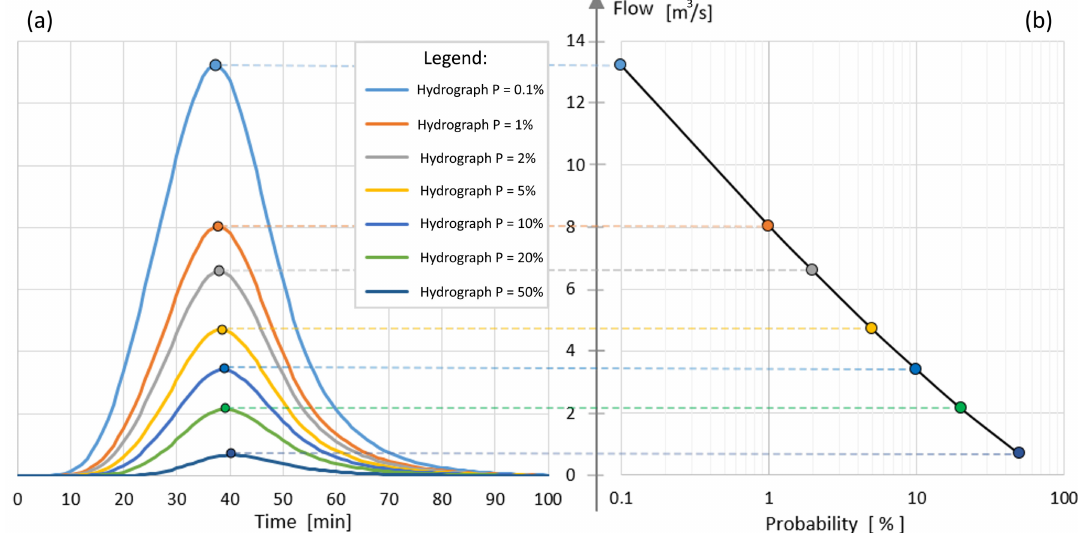
Figure 4. ( a ) Hydrographs of different probability of occurrence and ( b ) regression dependence between the peak value of runoff hydrograph and probability of occurrence of designed